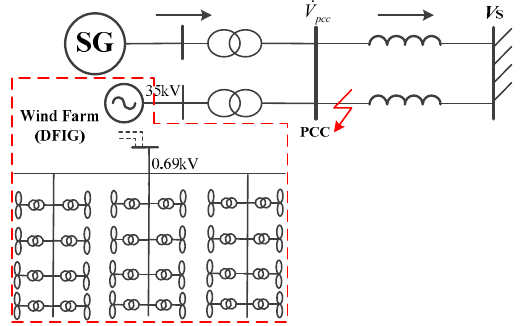
Figure 1. Grid connection system.